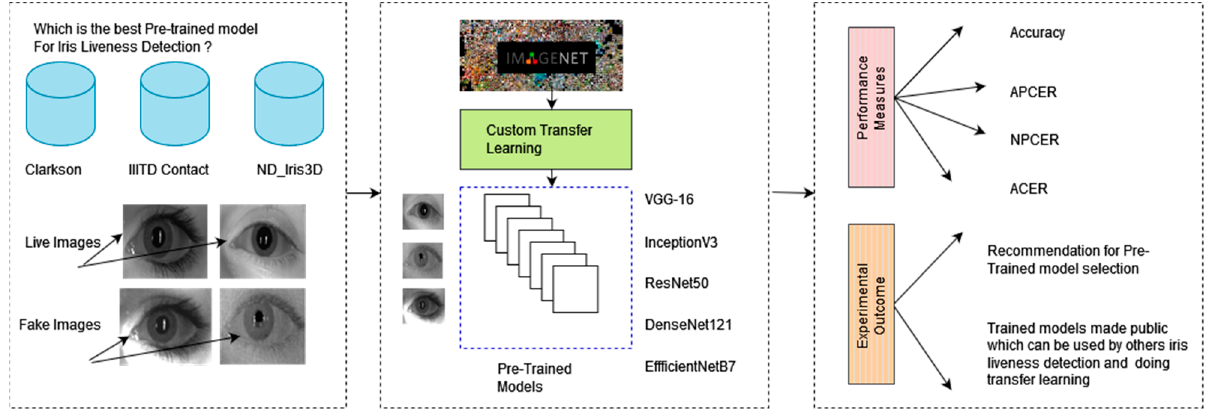
Figure 1. Graphical representation of the results of a study on the efficiency of transfer learning models for detecting iris liveness.